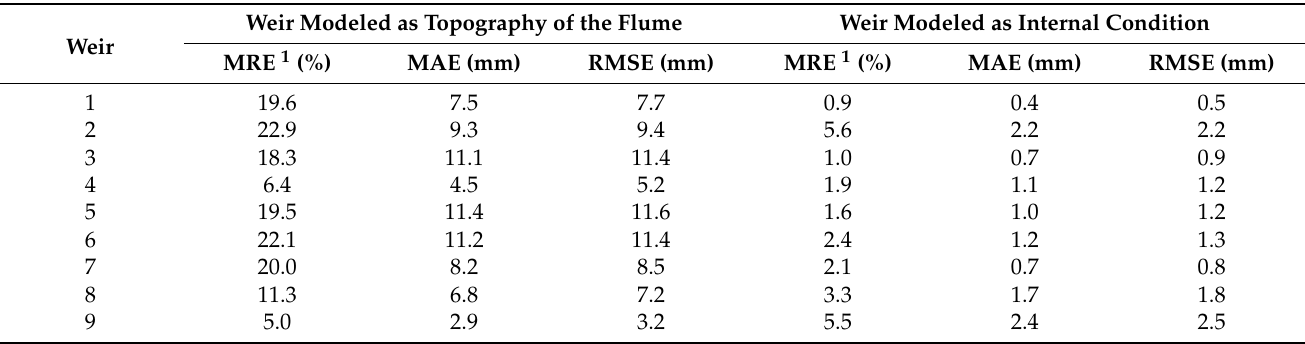
1 To calculate the mean relative error (MRE), the absolute error at each measurement point was divided by the water depth Table 3. Mean relative error (MRE), mean absolute error (MAE) and root mean square error (RMSE) values of the numerical above the crest of the weir at the same location. models in the comparison with the data obtained at the first experimental campaign.